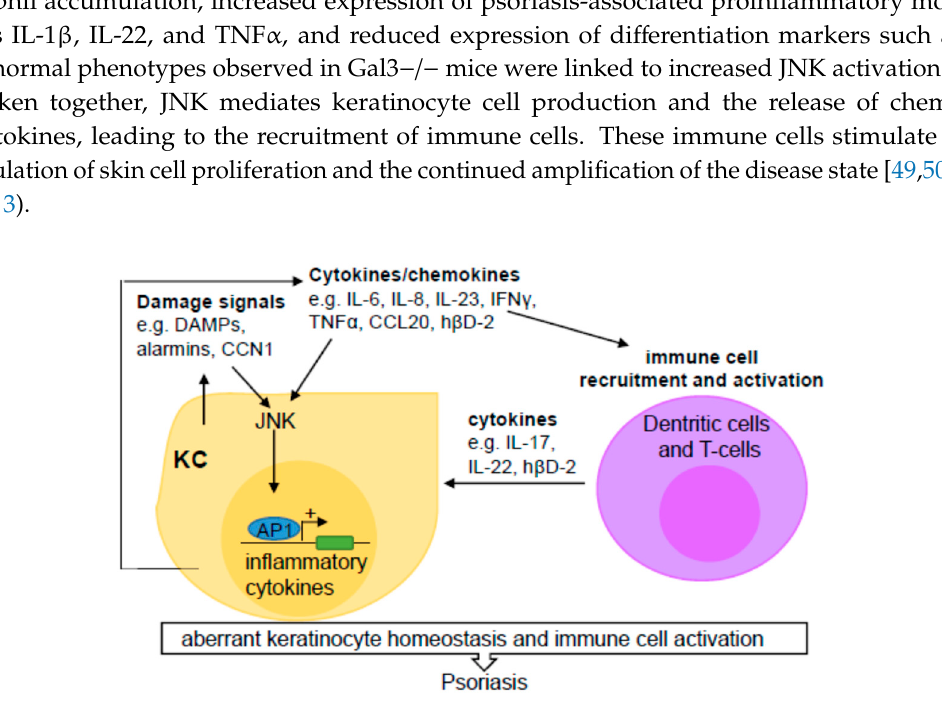
Figure 3. JNK modulates keratinocyte production of inflammatory cytokine / chemokines and recruitment of immune cells in psoriasis. Tissue damage signals (e.g., DAMPs, CCN1) activate the JNK signaling pathway in keratinocytes (KC), resulting in increased expression and release of inflammatory chemokines (e.g., CCL20, and h β D-2) and cytokines (e.g., IL-6, IL-8 IL-23, IFN γ , and TNF α ). These molecules not only propagate inflammatory signals in keratinocytes, but also stimulate recruitment and activation of Th1 / Th17 immune cells, which produce additional cytokines (e.g., IL-17, IL-22, and h β D-2), leading to propagated dysregulation of keratinocyte proliferation and differentiation and consequently development of psoriasis.